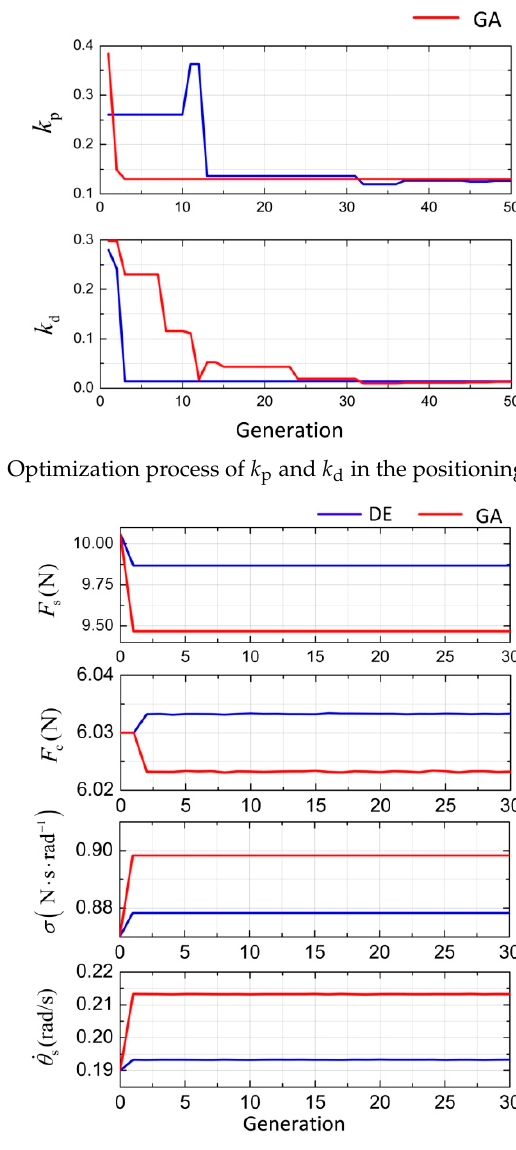
Figure 13. Identification process of the friction parameters in the positioning experiment.